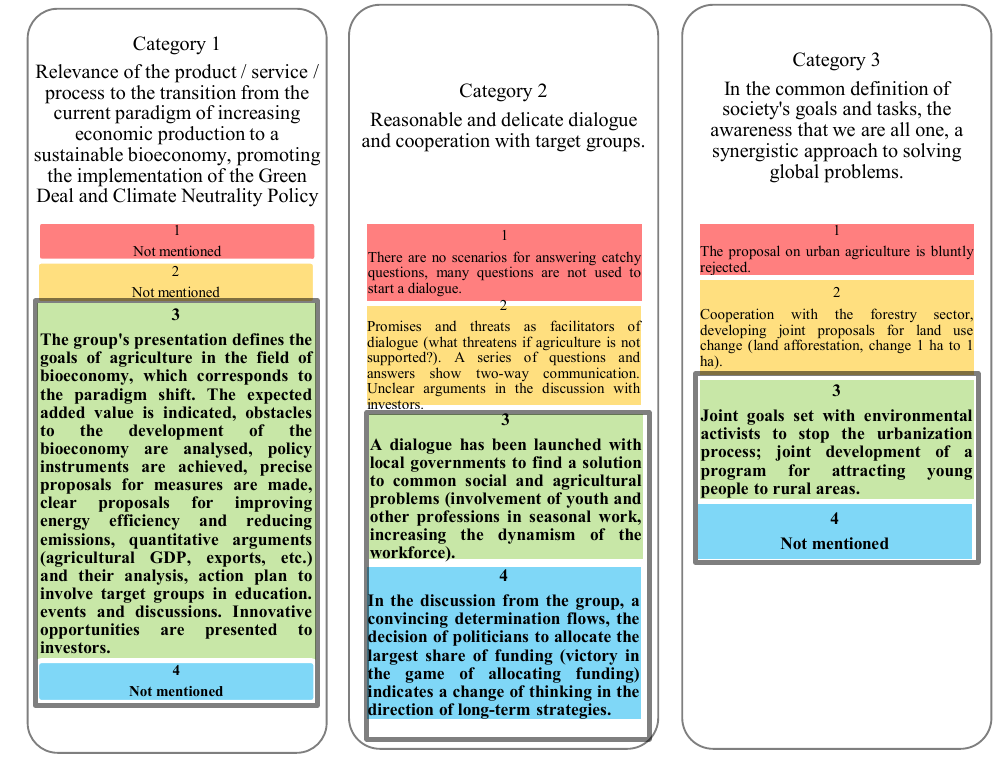
Fig. 3. Post-game performance level rubric for agricultural